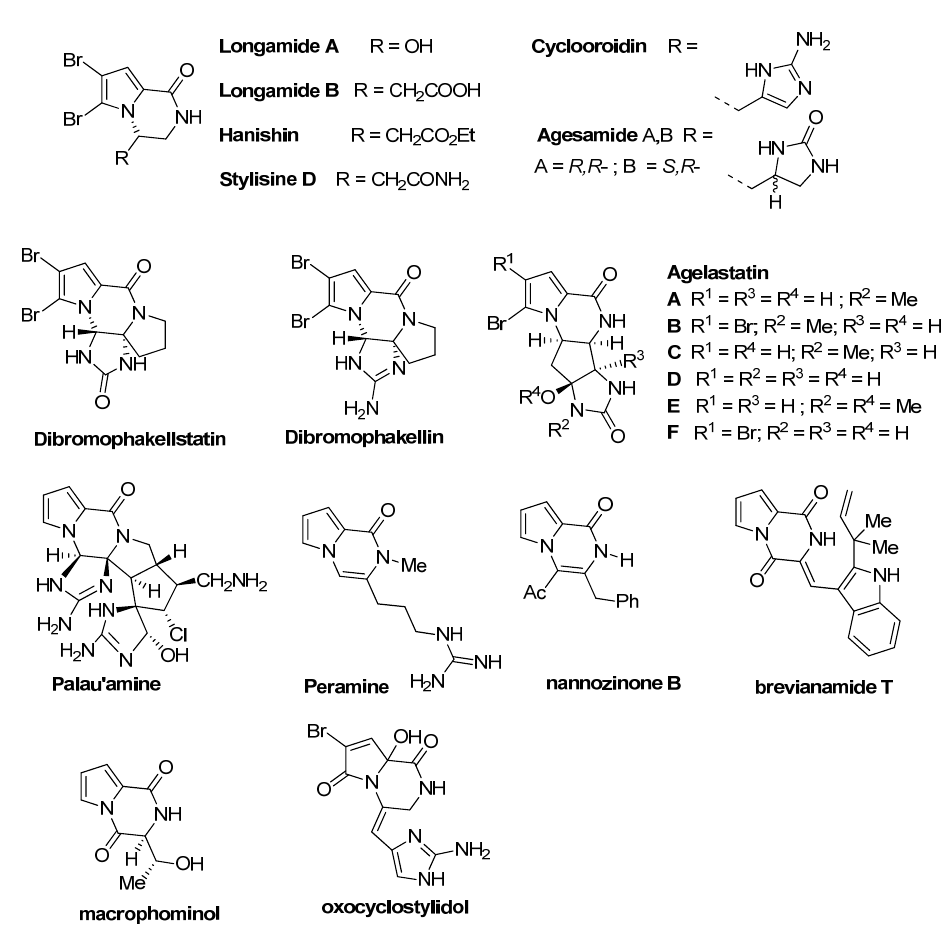
Figure 1. Pyrrolopyrazinone natural products.